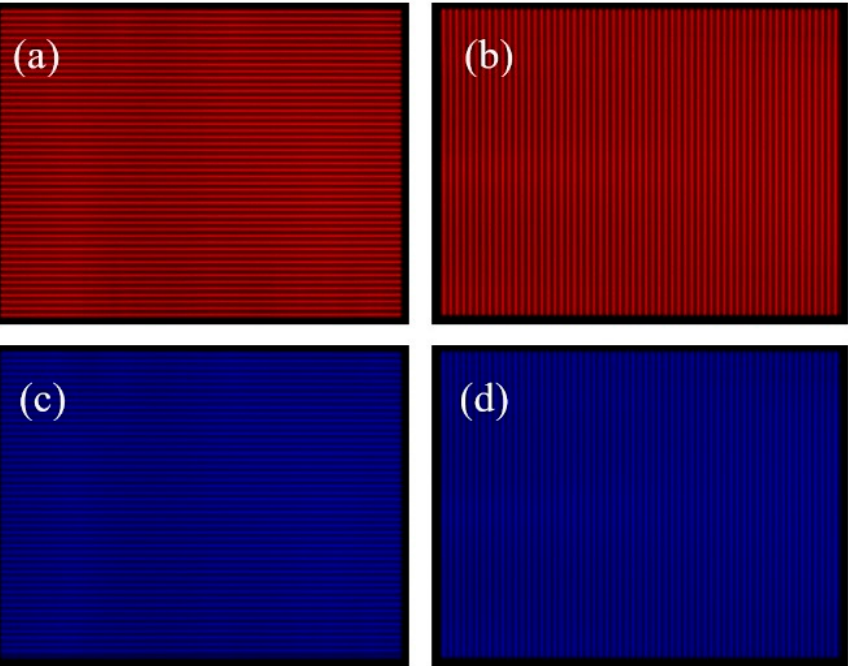
Figure 13. Pre-compensated fringe image: ( a ) red channel pre-compensated horizontal fringe image; ( b ) red channel pre-compensation vertical stripe image; ( c ) blue channel pre-compensation horizontal stripe image; ( d ) blue channel pre-compensation vertical stripe image.